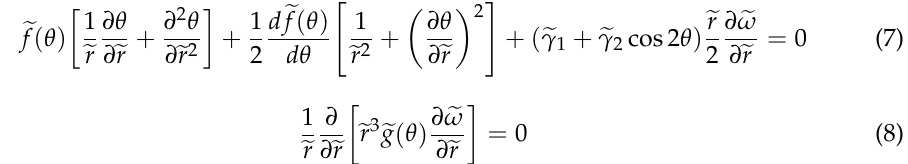
Table 1. Non-dimensionalized variables for Couette flow.